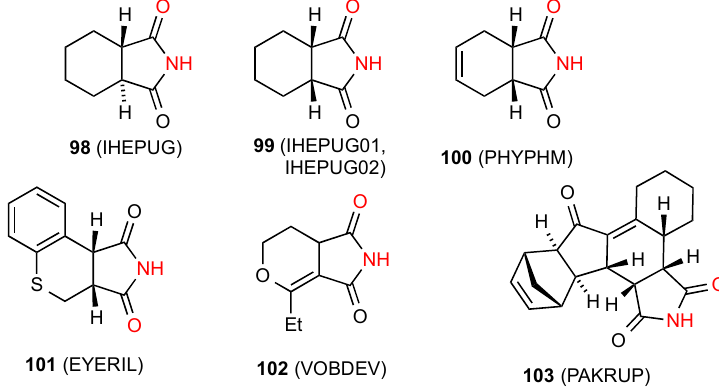
Figure 35. Six-membered ring-fused succinimides showing pattern B ribbons.